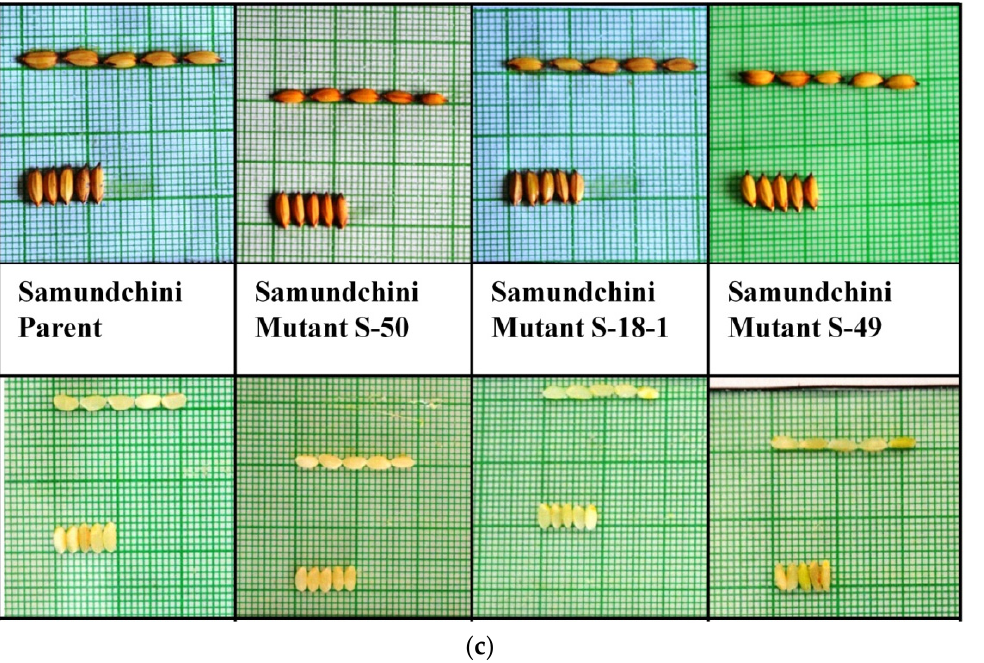
Figure 1. ( a ). Similarity in the lengths and widths of rough paddy and milled rice of Vishnubhog mutants with their corresponding parent Vishnubhog. ( b ). Similarity in the lengths and widths of rough paddy and milled rice of Jhilli mutants with their corresponding parent Jhilli. ( c ). Similarity in the lengths and widths of rough paddy and milled rice of Samundchini mutants with their corresponding parent Samundchini.